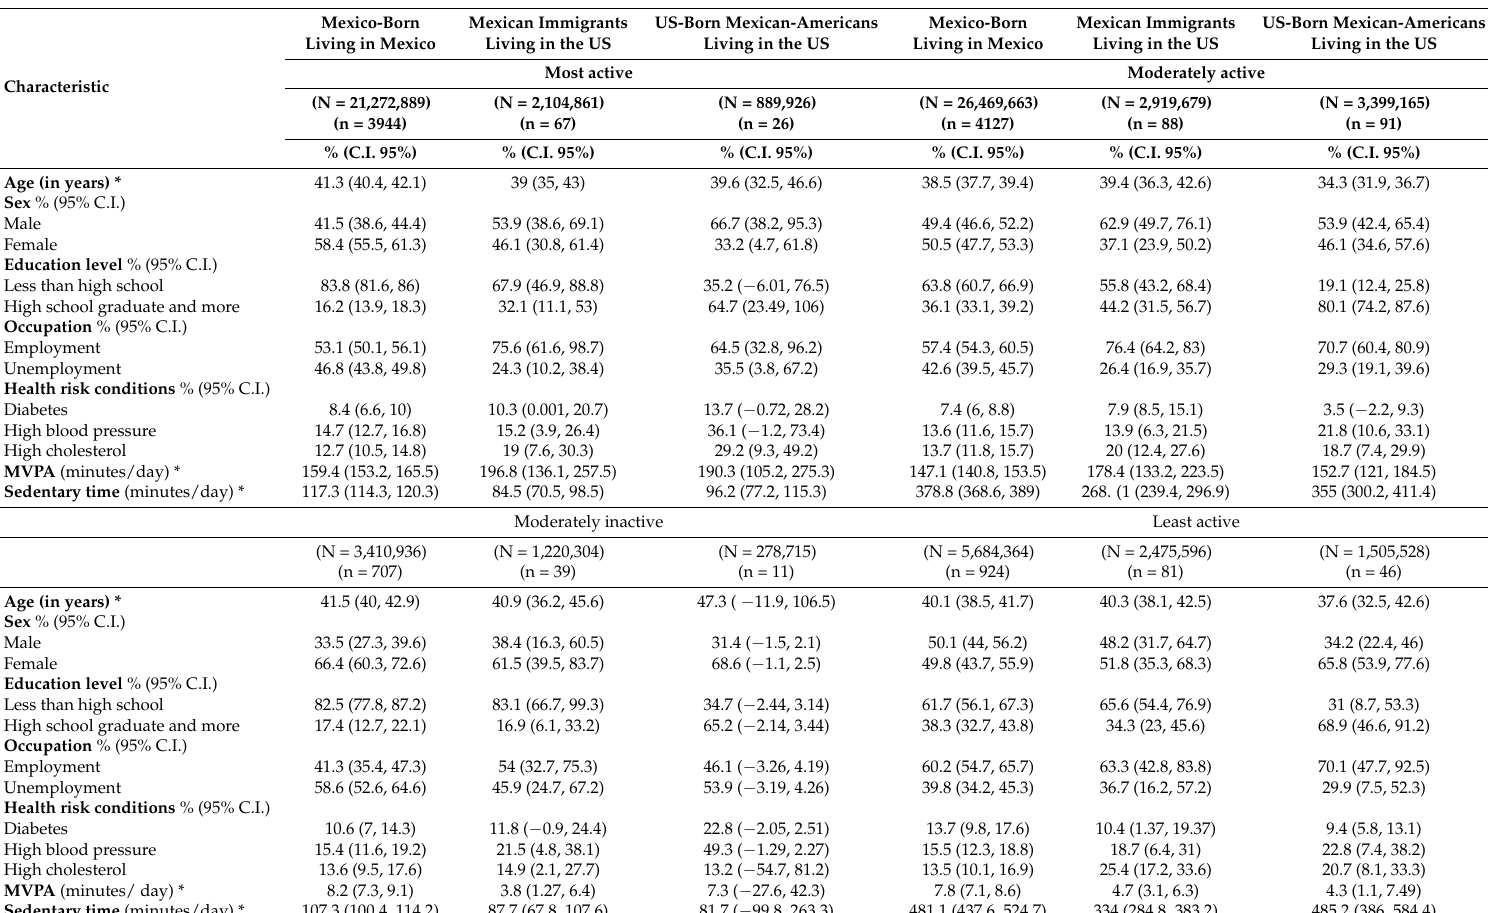
Table 1. Characteristics of the population with Mexican ethnicity according to joint categories of physical activity and sedentary behavior and migration status, birth place and country of residence. National Health and Nutrition Databases from the United States and Mexico (NHANES 2011–2012 and ENSANUT